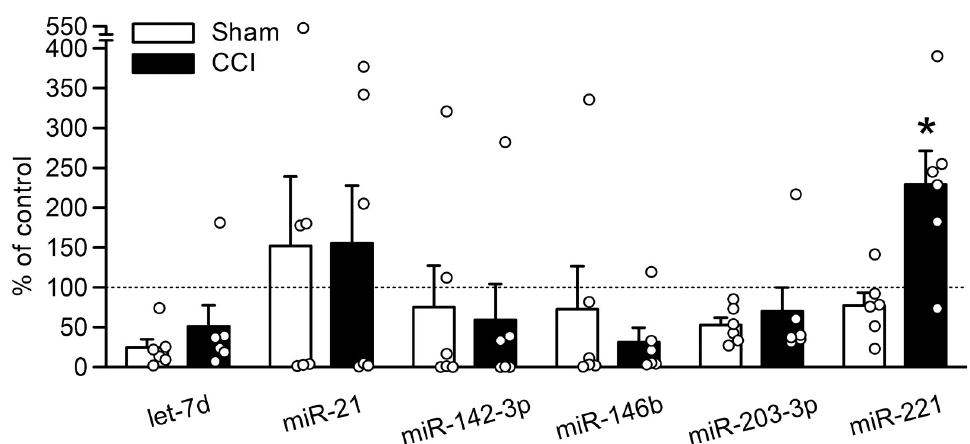
Fig 2. Serum levels of miRNAs after CCI. miRNA levels were examined in the EVs obtained from serum at day 7 after CCI ( n = 6–9) and were shown as a percentage of the mean expression in na ï ve rats. � P < 0.05, compared with sham operation (Mann–Whitney U -test).